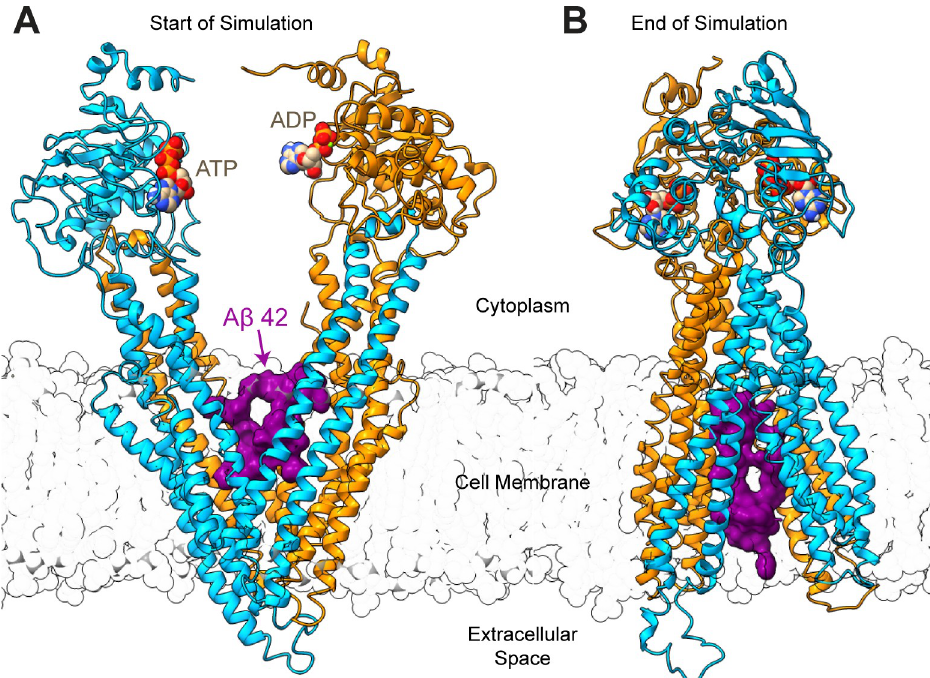
Fig 1. First and final frames of Targeted Molecular Dynamics (TMD) experiments—P-gp with amyloid- β . (A) The first frame of a representative simulation of A β 42 (PDB 1IYT) bound to the drug binding domains of P-gp. (B) The final frame of the same representative TMD simulation shown in (A). The N- and C-terminal halves of P-gp are colored turquoise or orange; A β 42 is shown in purple surface representation; ATP and ADP are bound at the nucleotide binding domains and shown in van der Waals